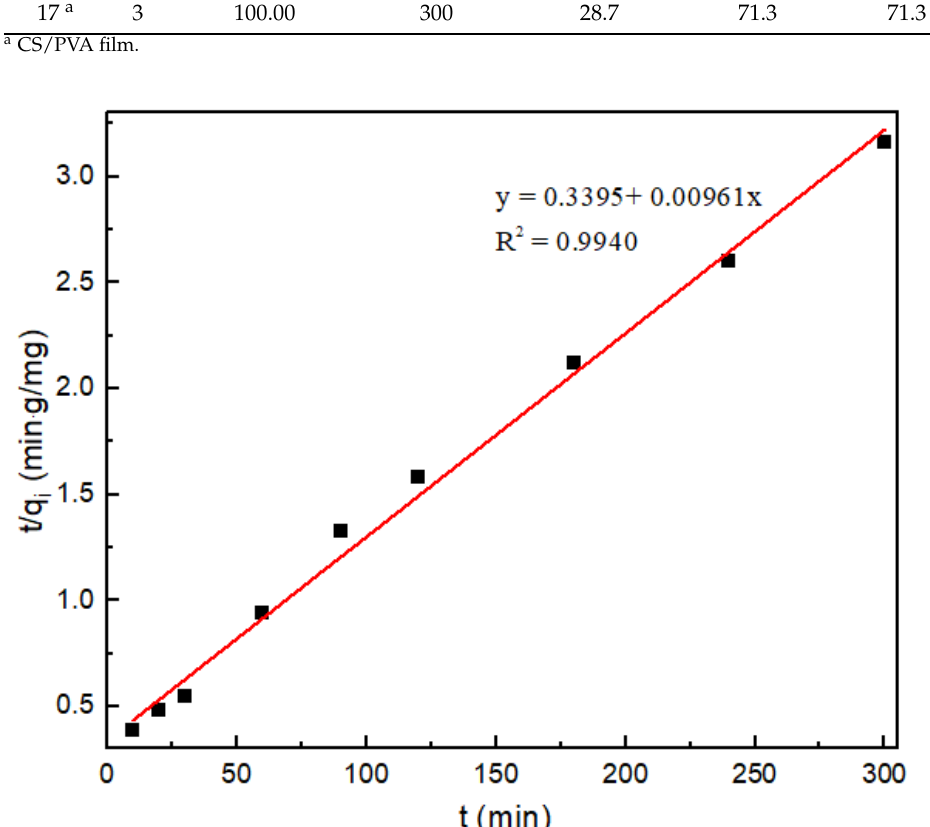
Figure 2. Adsorption of Pd 2+ by CS/PVA/MMT is consistent with the pseudo-second-order kinetic model.